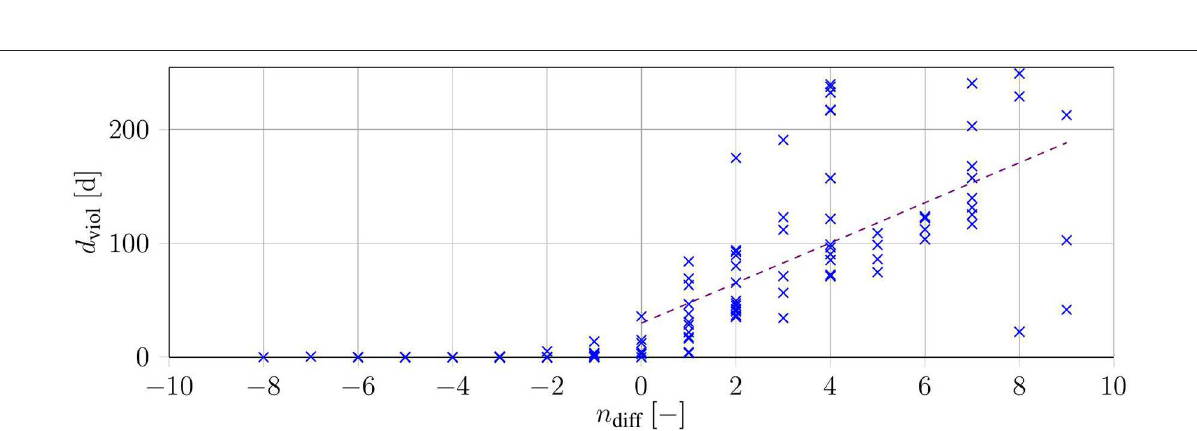
Frontiers in Physiology |